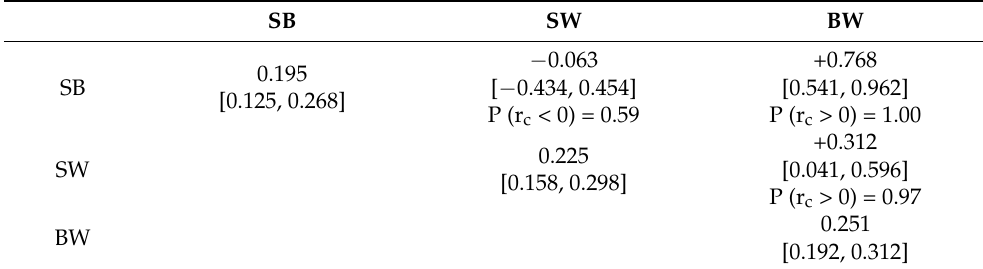
Table 9. Posterior means of phenotypic proportion of the litter variance (diagonal), and their correla- tions (above diagonal) for survival at birth (SB) and at weaning (SW), and individual birth weight (BW) after adjustment for litter